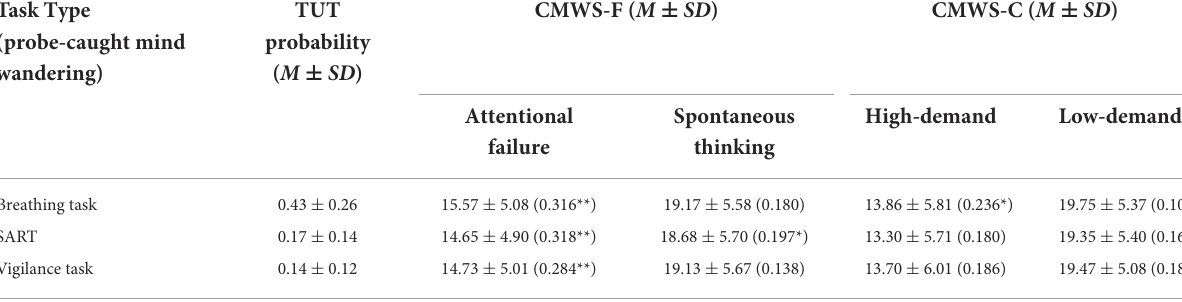
TABLE 5 Correlations between the frequencies of probe-caught mind wandering in tasks and the scores of the CMWS-F/CMWS-C in Study 2 (descriptive statistics included). Task